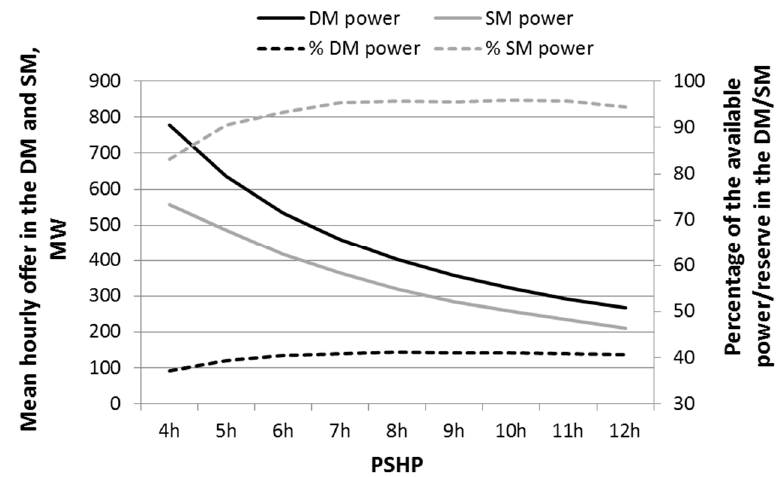
Figure 7. Mean hourly power generation in the DM/total reserves offered to the SM, for each PSHP (black/grey solid lines) and percentages of the total available power in the DM/reserve to the SM (black/grey dashed lines).